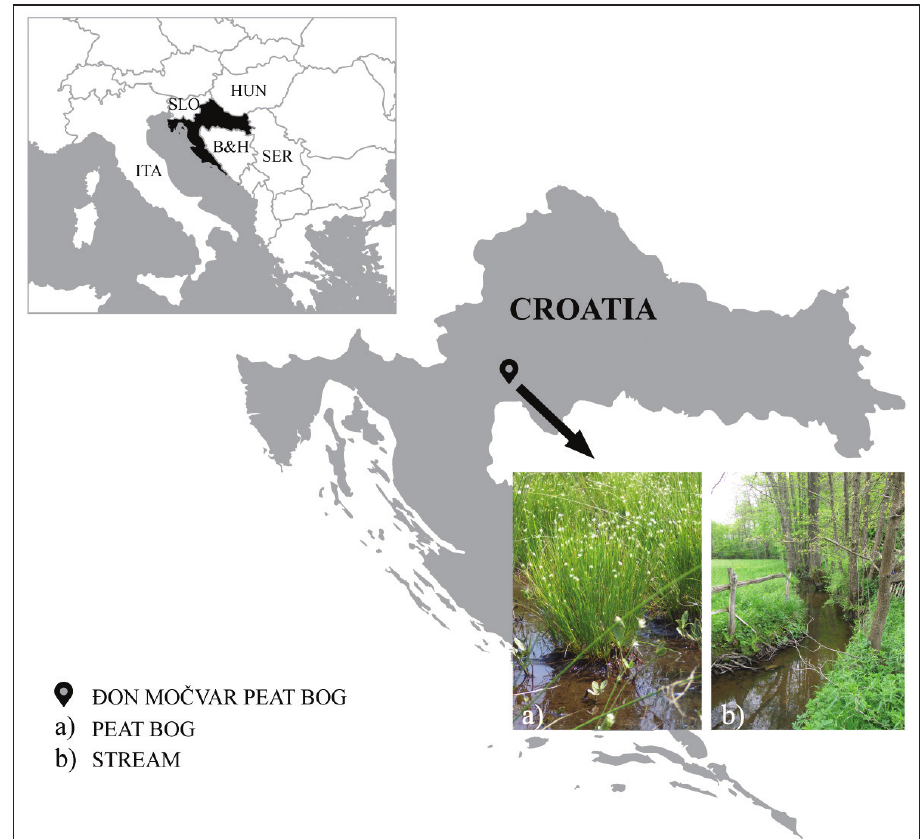
Figure 1. Geographical position of the Đon močvar peat bog,